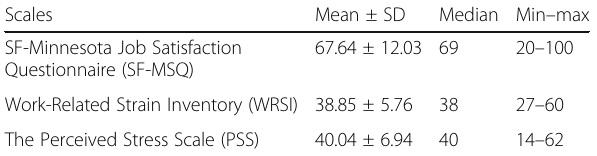
Table 4 Mean scores obtained by nurses from the SF- Minnesota Job Satisfaction Questionnaire, Work-Related